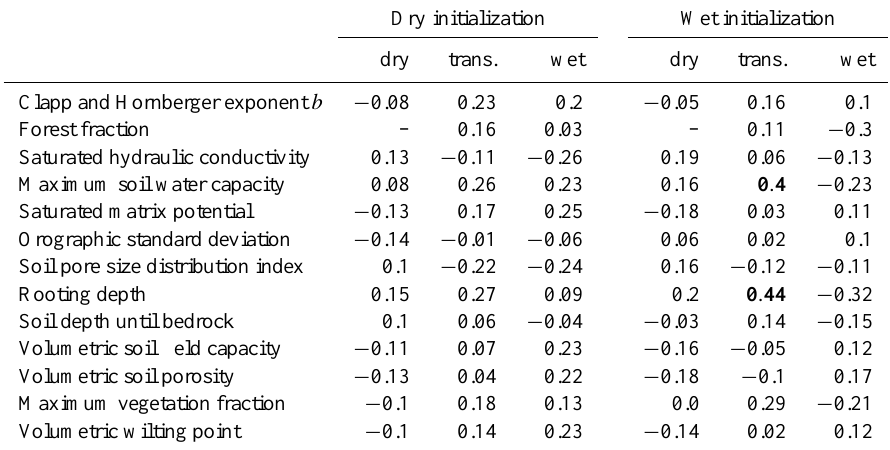
Table 1. Spatial March ensemble rank correlation coefficients between soil moisture τ 0 and static soil properties for different soil moisture regimes and initializations. Bold font indicates significant correlation ( p < 0 . 05).